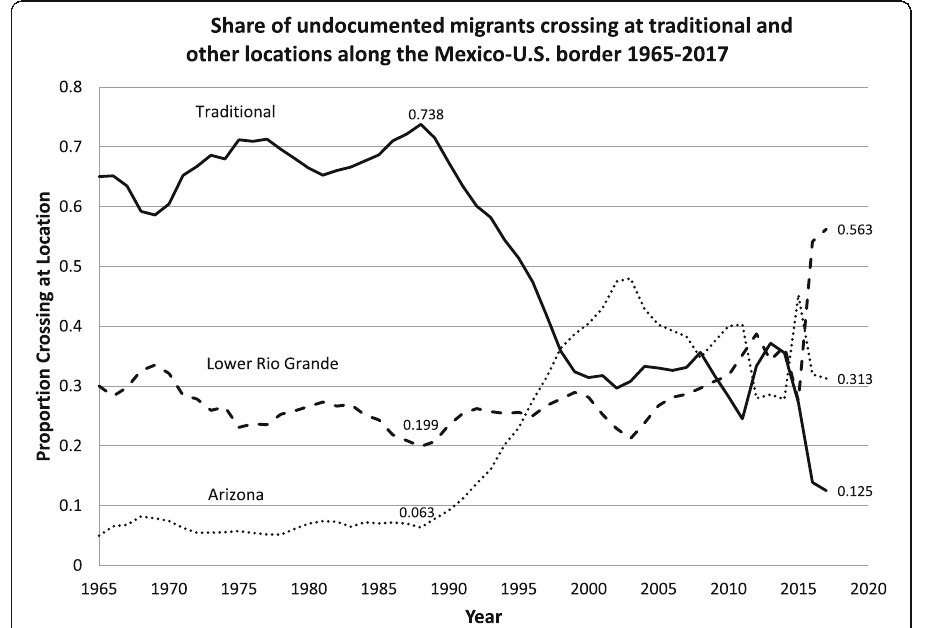
Fig. 6 Share of undocumented migrants crossing at traditional and other locations along the